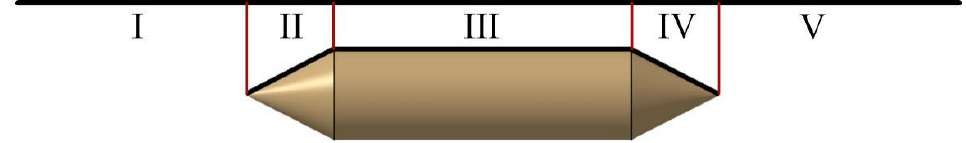
Figure 7. Schematic diagram of partition for flow field in the tube.